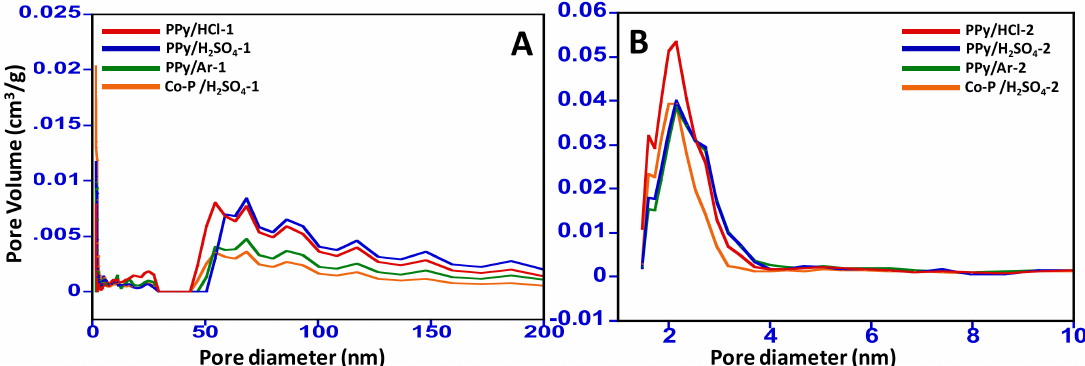
Figure 4. Pore size distribution for ( A ) N-GOs obtained when carbonization and activation were carried using polymer: KOH at a ratio of 1:2 and ( B ) N-GOs obtained when carbonization and activation were carried using polymer: KOH at a ratio of